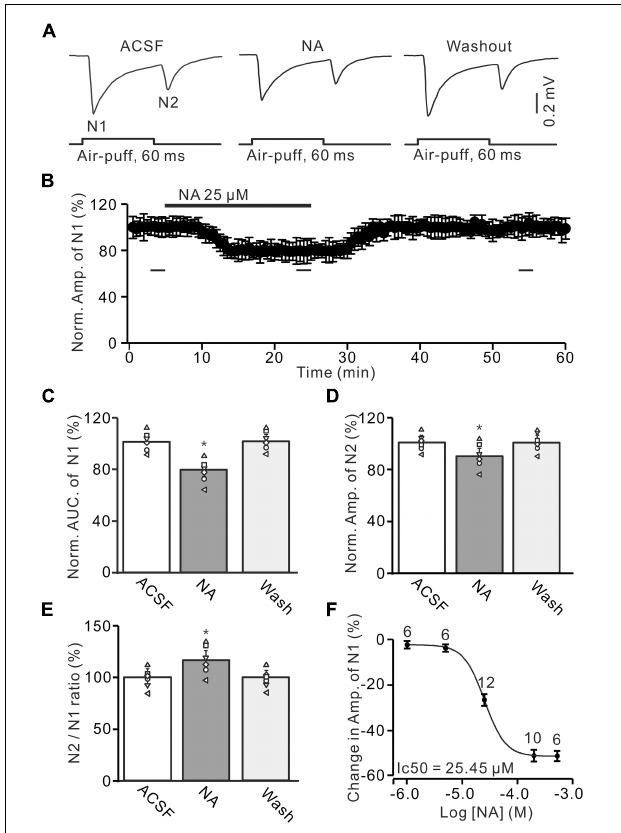
FIGURE 1 | Noradrenaline (NA) depresses the facial stimulation-evoked mossy fiber-granule cell (MF-GC) synaptic transmission in mouse cerebellar cortex. (A) Representative field potential recording traces showing the air-puff stimulation (60 ms, 60 psi) evoked MF-GC synaptic transmission in a mouse cerebellar GL during treatment with artificial cerebrospinal fluid (ACSF), NA (25 µ M) and recovery (washout). (B) Summary of data showing the time course of normalized amplitude of N1 during NA application. Bars denote the data points which were used for panels (C–E) in treatments with ACSF, NA, and washout. (C) Mean value ( ± SEM) with individual data showing the normalized area under the curve (AUC) of N1 in treatments with ACSF, NA, and recovery (washout). (D,E) Mean value ( ± SEM) with individual data showing the normalized amplitude of N2 (D) and the N2/N1 ratio (E) in treatments with ACSF, NA and recovery (washout). (F) The concentration-response curve shows the NA-induced decrease in amplitude of the facial stimulation-evoked of N1. The IC 50 value obtained from the curve was 25.45 µ M. The number of recordings tested for each concentration is indicated near the bars. * p < 0.05 versus control (ACSF); n = 6 in each